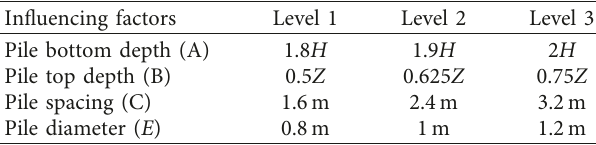
Figure 41: Difference between the additional shear Table 13: Influencing factors and levels.